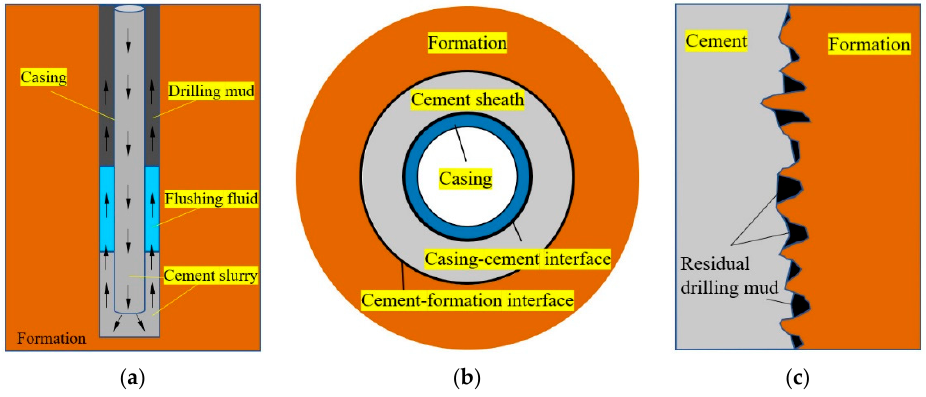
Figure 1. Primary cementing and casing–cement–formation system. ( a ) Primary cementing, ( b ) Casing–cement–formation structure, ( c ) Cement–formation interface.